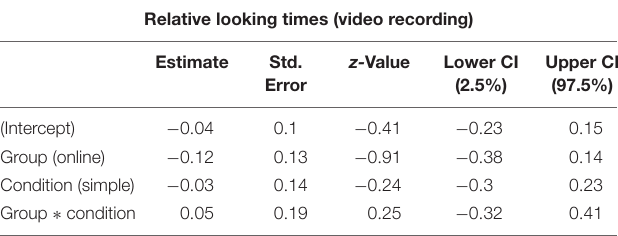
TABLE 2 | Results of the GLMM of trial-level relative looking times to the synchronous stimulus measured with video recording, with estimates, standard errors, z -values, and confidence intervals